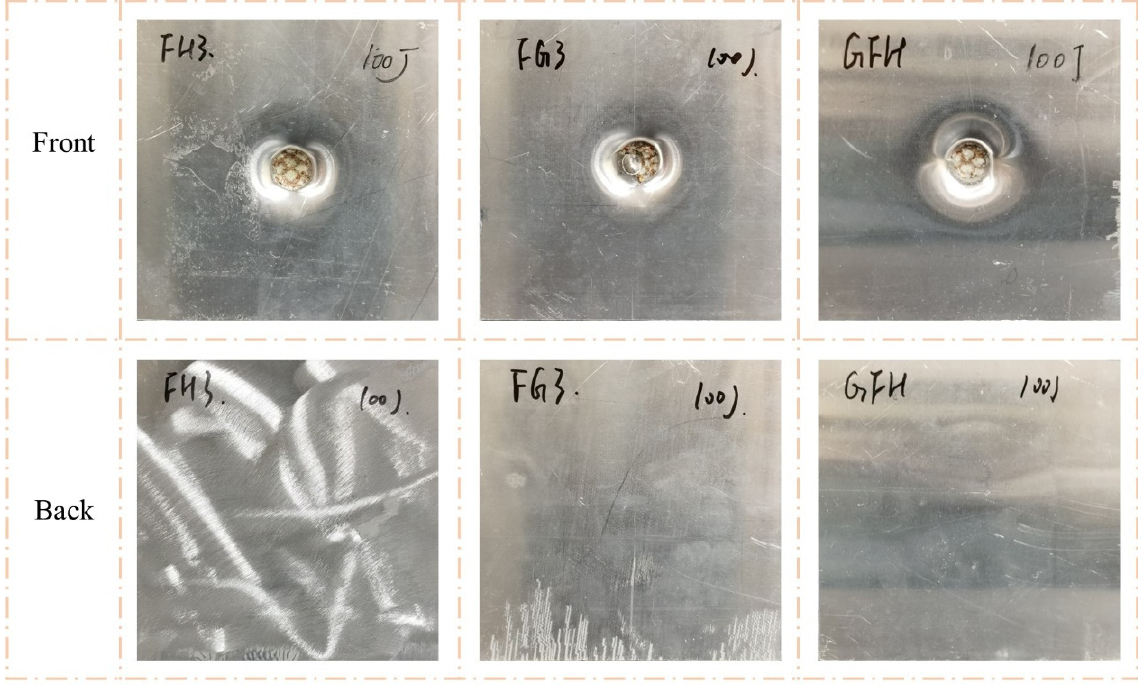
Figure 10. Damage modes of FH3, FG3, and GFH under 100 J impact energy with hemisphere im- pactor.